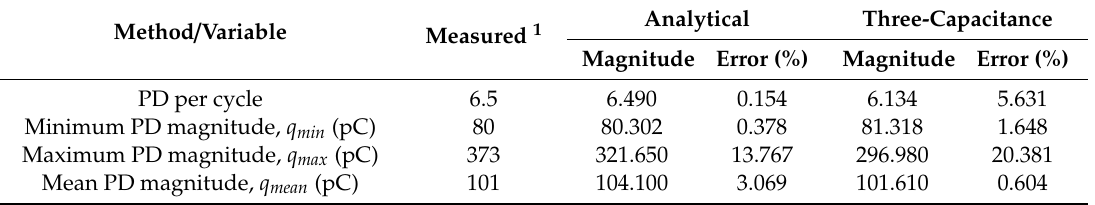
Table 9. Simulation results summary and measured values for the case